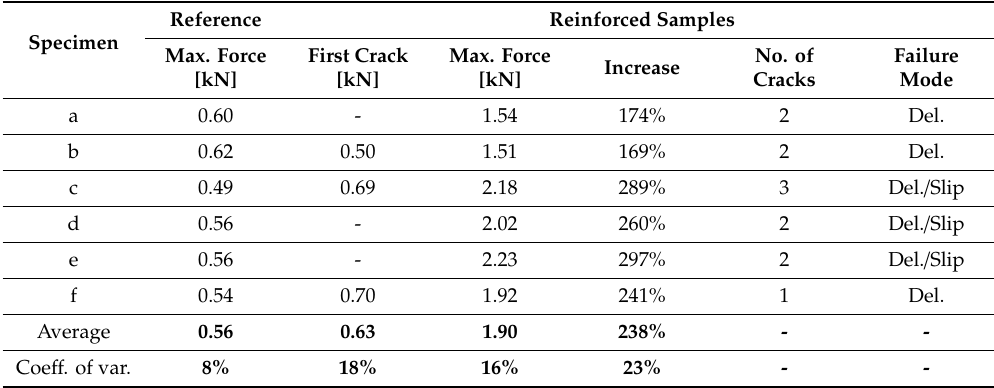
Table 4. Results of bend tests on specimens with a cross-section of 25 mm × 20